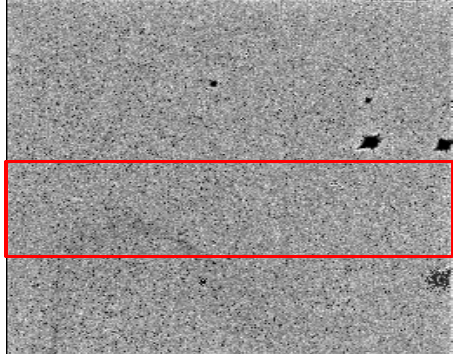
Figure 1. An x-ray image of air acquired by the CdTe photon counting spectral detector at 60 kVp, 217 μA. The exposure time was 1 s. Only good pixels in the red-marked region were used for the energy calibration avoiding the dead pixel clusters.